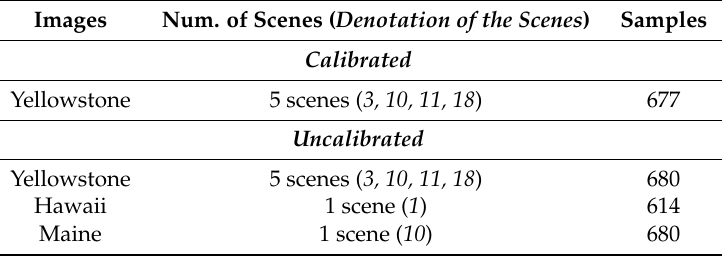
Table 11. Description of the CCSDS dataset.